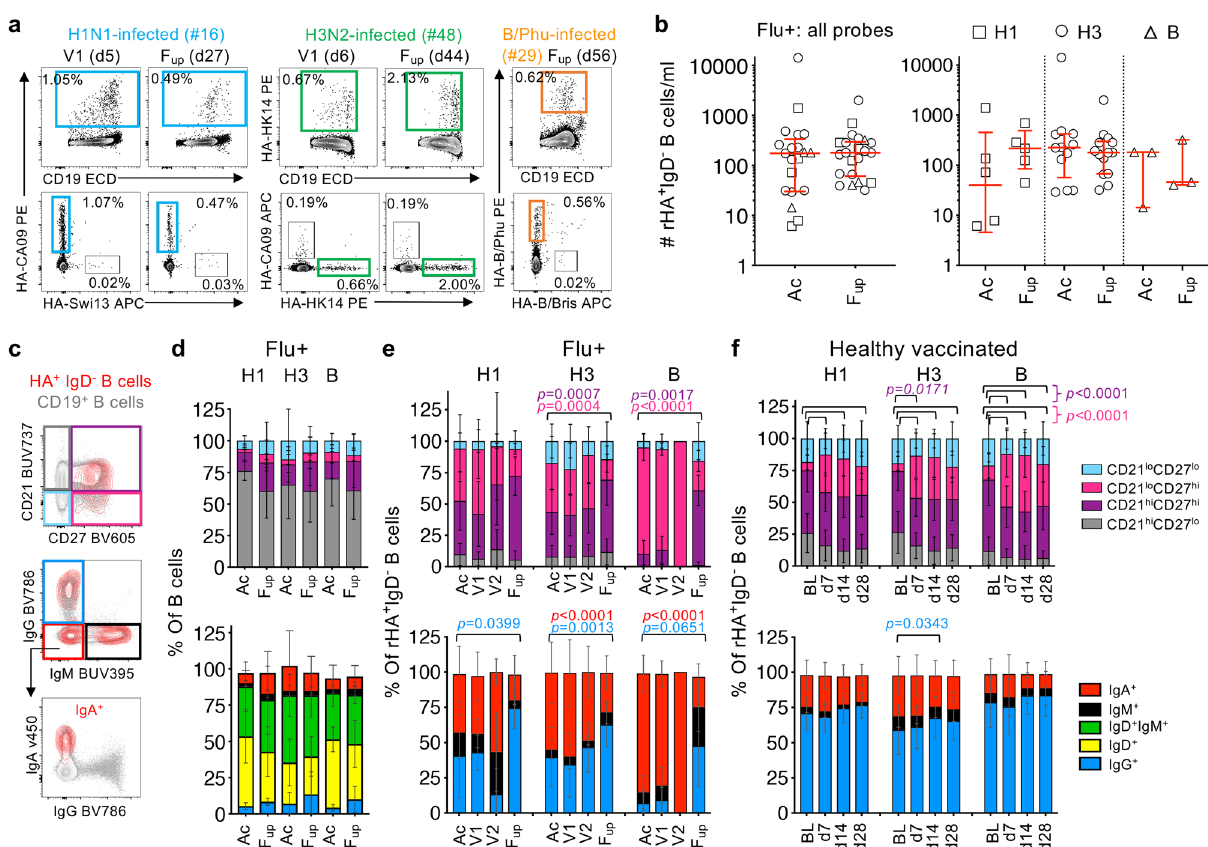
Fig. 4 Contrasting in fl uenza-speci fi c B cell responses between in fl uenza infection and vaccination. a Representative FACS plots of H1-, H3- and B- speci fi c rHA + B cells at V1 and F up timepoints (days after disease onset in brackets). b Numbers of total rHA + B cells and per H1-, H3- and B-speci fi c rHA + B cells at acute (Ac) ( n = 21) and F up timepoints ( n = 22). Red bars indicate the median and IQR for cell numbers. c Representative overlay FACS plots of live total B cells and rHA + B cells from IBV-infected patient #29 at F up for phenotype and isotype characterization. d – f Phenotype (top panel) and isotype (bottom panel) distributions of ( d ) total B cells and ( e ) rHA + B cells in in fl uenza + (Flu + ) patients at acute (Ac = V1 and V2, V1, V2) and follow-up timepoints in comparison to ( f ) healthy vaccinated controls ( n = 41) pre-vaccination at baseline (BL) and d7, 14 and 28 post-vaccination. d – f Bars indicate the mean and SD for frequencies. e , f Statistical signi fi cance (0.0001 > p < 0.05) was determined using a two-tailed Tukey ’ s multiple comparison test. Colored p values refer to each group legend within the